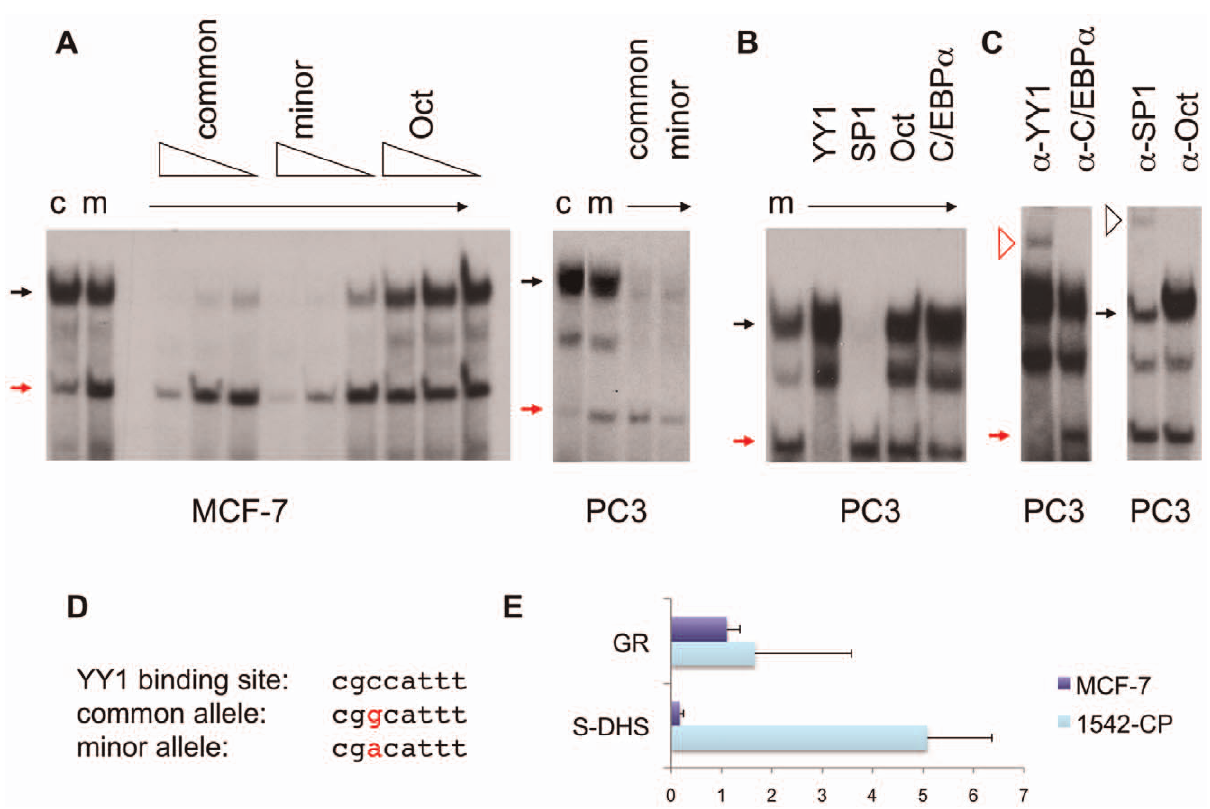
Figure 2. Protein DNA interactions at the sequences overlapping rs378854. (A) Electrophoretic mobility shift assays (EMSA) were carried out with oligonucleotides containing the common (c) and minor (m) alleles of rs378854 and nuclear extracts from the breast cancer cell line MCF-7 and the prostate cancer cell line PC3. Competitor oligonucleotides were present at 100-, 30- and 10-fold excess for MCF-7 and 30-fold excess for PC3 and are indicated above the lanes. The red and black closed arrows denote the YY1 and SP1 complexes, respectively. (B) EMSAs of the oligonucleotide containing the minor allele were carried out with PC3 nuclear extract and 30-fold excess of competitor oligonucleotides as shown. (C) Supershift of the complex using polyclonal antibody against YY1, SP1, Oct-1 and C/EBP a with PC3 nuclear extracts. The red and black open arrows denote the YY1 and SP1 supershift complexes. (D) An alignment of the two alleles with a YY1 binding site [28] is shown. (E) Chromatin immunoprecipitation assay showing the fold-enrichment of the S-DHS and the positive control (glucocorticoid receptor, GR) sequences relative to a negative control (S-DHS-ve) after immunoprecipitation with YY1 antibody in MCF-7 breast 1542-CP prostate cancer cells.